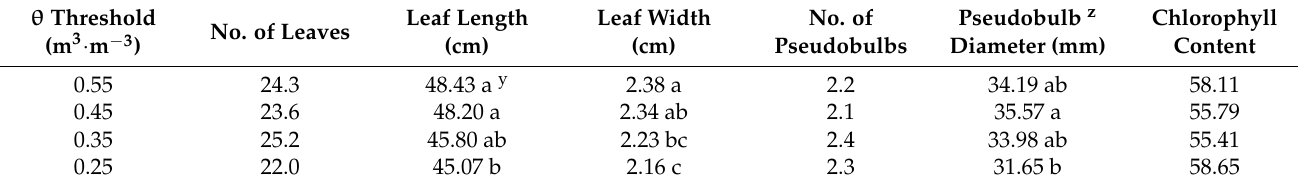
Table 1. Vegetative growth characteristics of 1-year-old cymbidium “Hoshino Shizuku” with a frequency domain reflectometry (FDR) sensor-based irrigation system for 42 weeks as influenced by different substrate volumetric water content ( θ ) thresholds (m 3 ·m − 3 ).